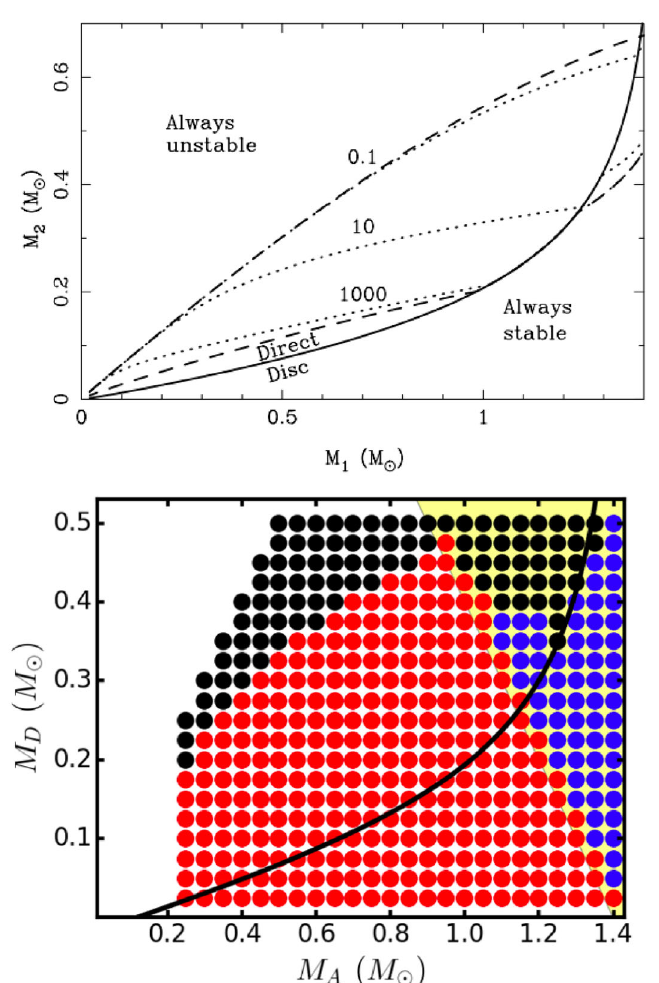
Fig. 14 Stability regions in the donor mass — accretor mass plane of WD ? WDs and UCXBs. Donor star masses are on the vertical axes, accretor star mass on the horizontal axes. Upper panel: analytical results of Marsh et al. (2004) where the solid line marks the transition between disc and direct impact accretion, and the other lines show how the strict stability limit of Nelemans et al. (2001a) is relaxed when dissipative torques feed angular momentum from the accretor back to the orbit. Bottom panel: ballistic calculation approach by Kremer et al. (2017) using zero-temperature mass – radius relations for the WD donor. Red systems are stable throughout their lifetimes, through stages of both direct-impact and disc accretion; black systems are unstable; and blue systems have an accretor that exceeds the Chandrasekhar limit during their evolution. The solid black line marks again the boundary between disc and direct-impact accretion for initially synchronous and circular binaries. The yellow region indicates systems with a total mass in excess of the Chandrasekhar limit, i.e. potential SN Ia progenitors. It is evident from these fi gures that UCXBs with low-mass ( . 0 : 2 M (cid:3) ) He WD donor stars, and NS accretors, are always dynamically stable. Images reproduced with permission from [top] Marsh et al. (2004), copyright by RAS; and [bottom] from Kremer et al. (2017), copyright by